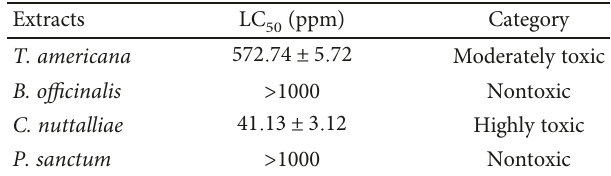
Table 1: Toxic activity on A. salina based on LC extract. Values are expressed as mean ± SD